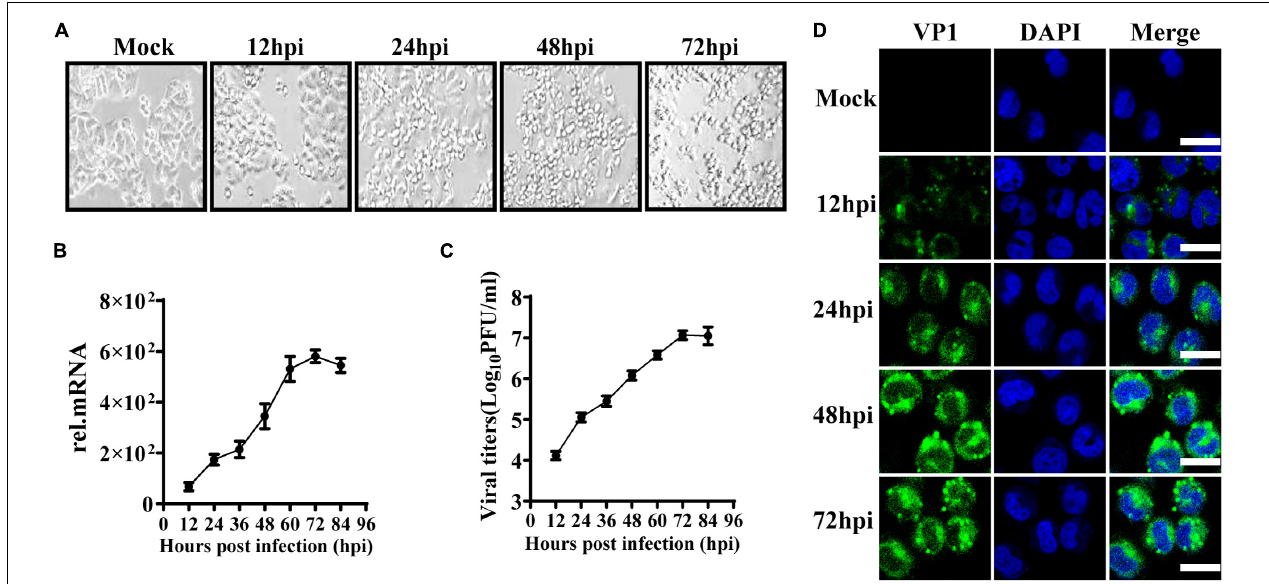
FIGURE 1 | EV71 can replicate in human intestinal epithelial cells. (A) HT29 cells were inoculated with EV71 at an MOI of 1, and the images were obtained at the indicated time points. Representative images were shown. (B) The kinetic curve of EV71 replication in HT29 cells. HT29 cells and culture supernatants were harvested at indicated time points (MOI = 1). Total RNAs were extracted for reverse transcription (cDNA) to determine the mRNA level of EV71-VP1 using VP1 specific primers by qRT-PCR, and dates were calculated relative to GAPDH gene expression. (C) The cell culture supernatants were collected for virus titer detection by plaque assay. (D) HT29 cells were fixed in 4% paraformaldehyde at the indicated infection time points, then incubated with anti-EV71 VP1 antibody, followed by staining with Alexa Fluor 488-conjugated secondary antibody and DAPI to visualize the EV71 and nuclei. Olympus confocal laser scanning microscope was used for imaging. Mock was cells without infection. The results were presented from three independent experiments as mean ±